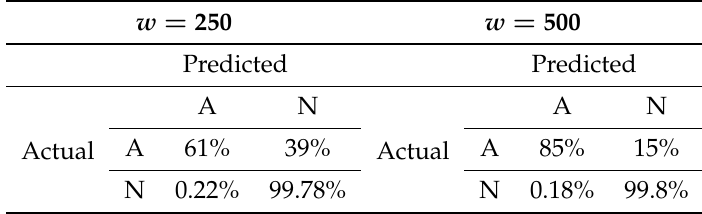
Table 3. Confusion matrix for A (attack) and N (normal)